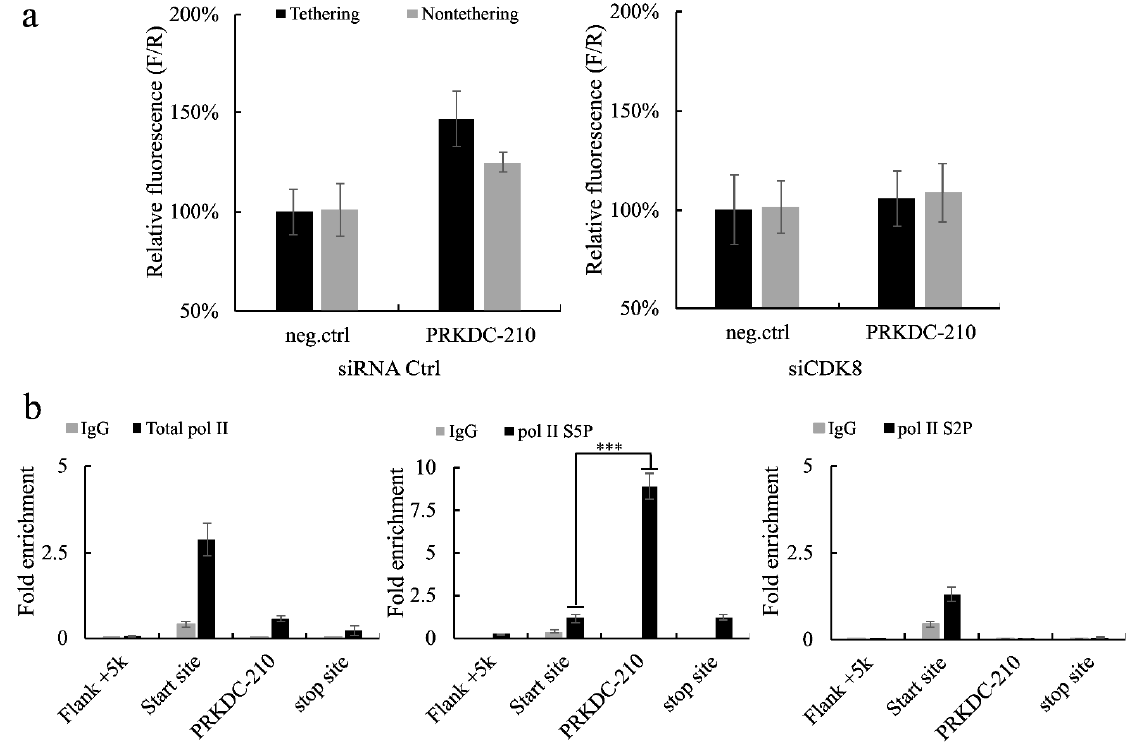
Figure 2. ( a ) This figure shows the expression of luciferase after tethering of PRKDC-210 in control siRNA-treated HEK293T cells and siCDK8-treated HEK293T cells. F/R, firefly luciferase/Renilla luciferase. ( b ) RIP-qPCR assays of MCF7 cells using antibodies targeting total RNA pol II, RNA pol II S5P, and RNA pol II S2P. The enrichment of PRKDC mRNA at different sites and the enrichment of PRKDC-210 in different phosphorylation of RNA Pol II are shown. Data in all panels are represented as the mean ± s.e.m. of three independent experiments. *** p < 0.001 by a two-tailed Student’s t -test.